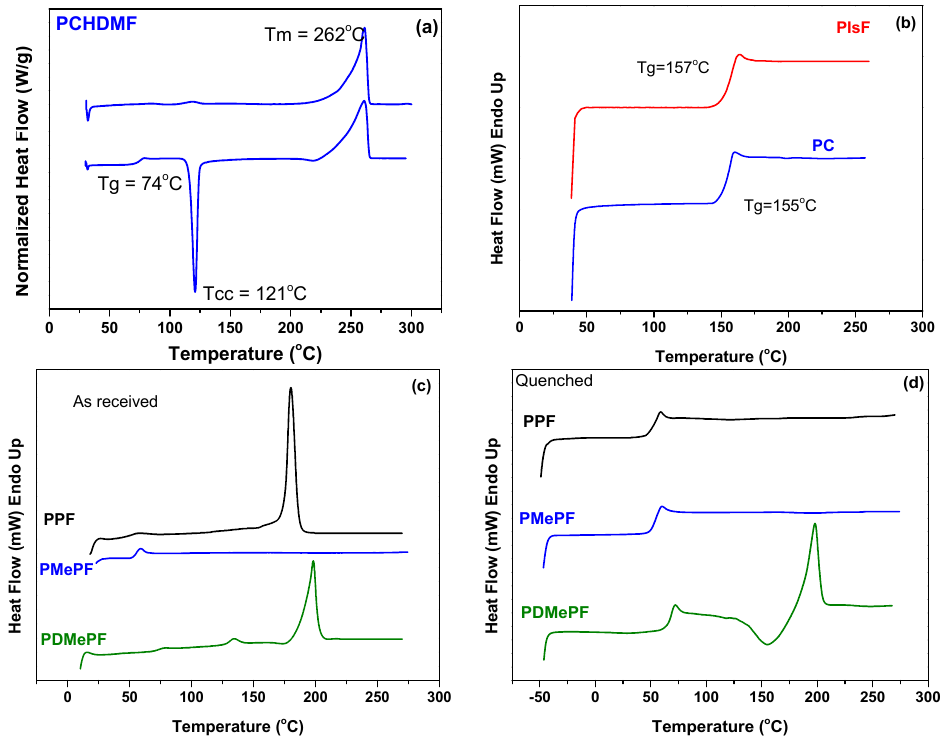
Figure 4. DSC scans of the prepared furanoate polyesters: ( a ) for as received and melt quenched PCHDMF; ( b ) for PIsF and PC; and ( c , d ) for as received and melt quenched PPF, PMF, and PDMePF.